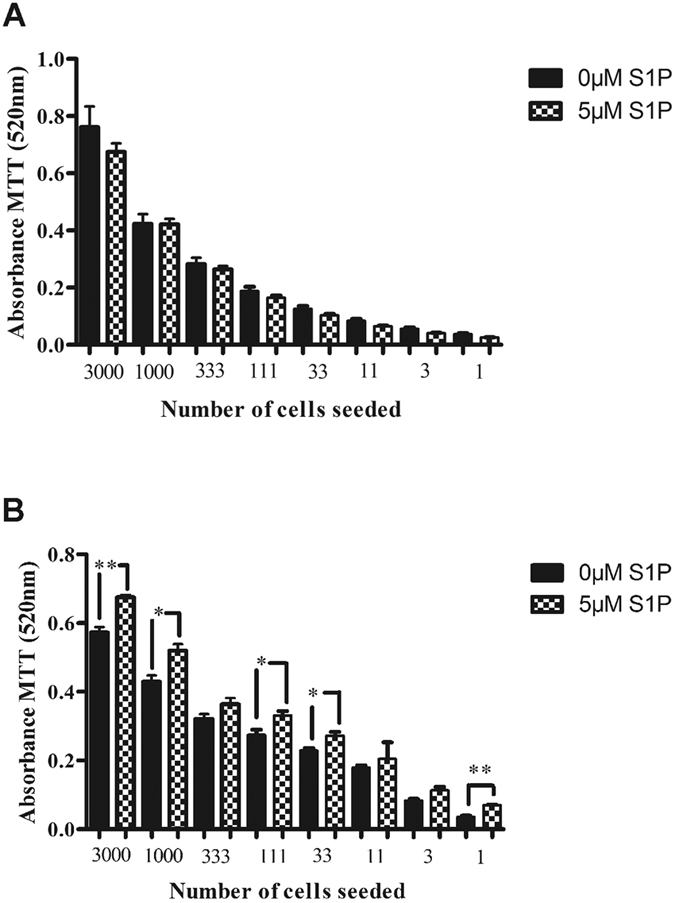
Effect of S1P on Cisplatin-induced apoptosis.H357 cells were either untreated (A) or were incubated for 3 hours with 1 μM Cisplatin (B) in serum free media in the presence or absence of 5 μM S1P. Twenty four hours later the cells were harvested, and replated in a 96-well plate in complete media using 1 in 3 serial dilutions. After 7 days in culture, an MTT assay was performed. Graphs show the mean ± standard deviation of three experiments performed in triplicate. **P < 0.05, ***P< 0.001 (Unpaired t-test).